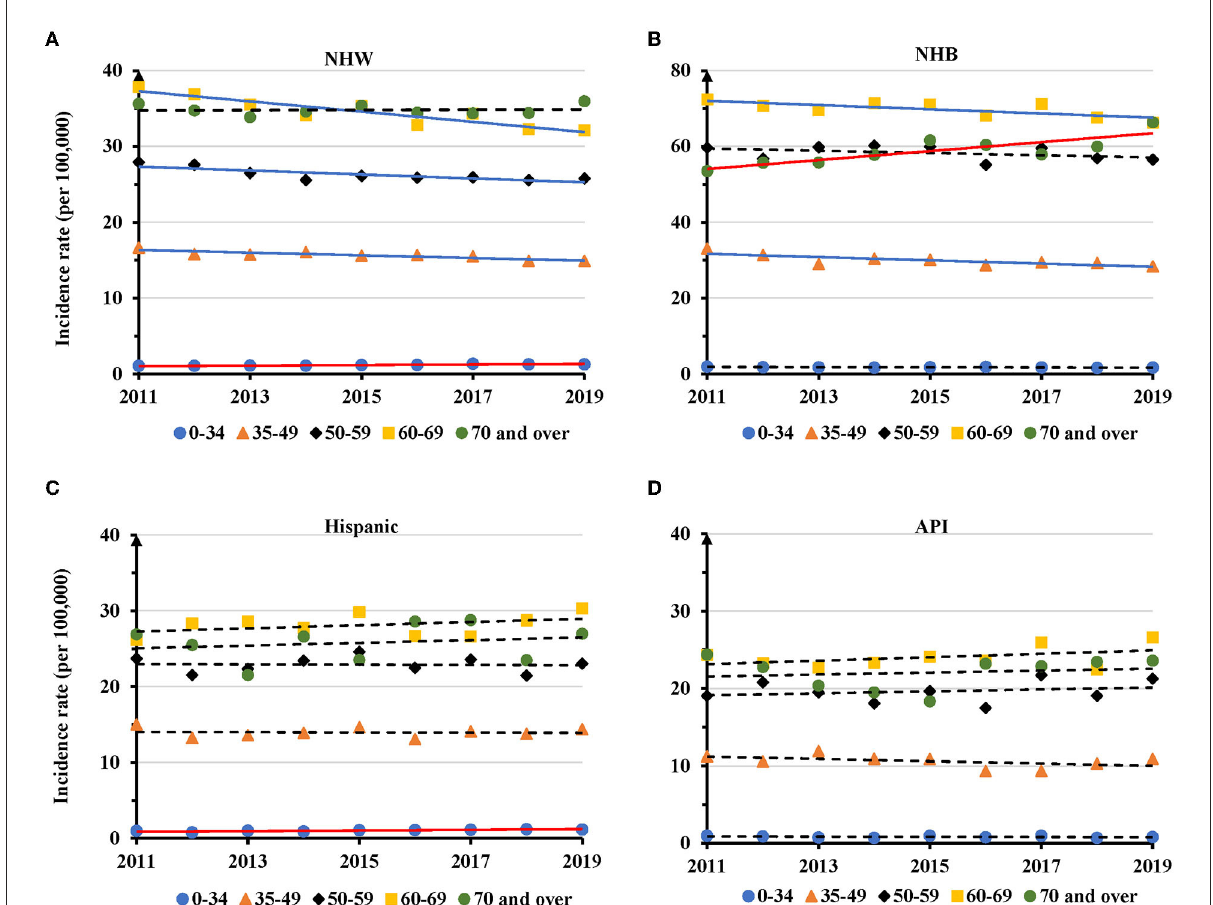
FIGURE4 Temporal changes in age adjusted incidence rates of TNBC by age group in individual races during 2011–2019. (A) NHW. (B) NHB. (C) Hispanic. (D) API. Solid lines indicate significant change in annual percentage change (APC) of age adjusted incidence rate. Dashed lines show no significant